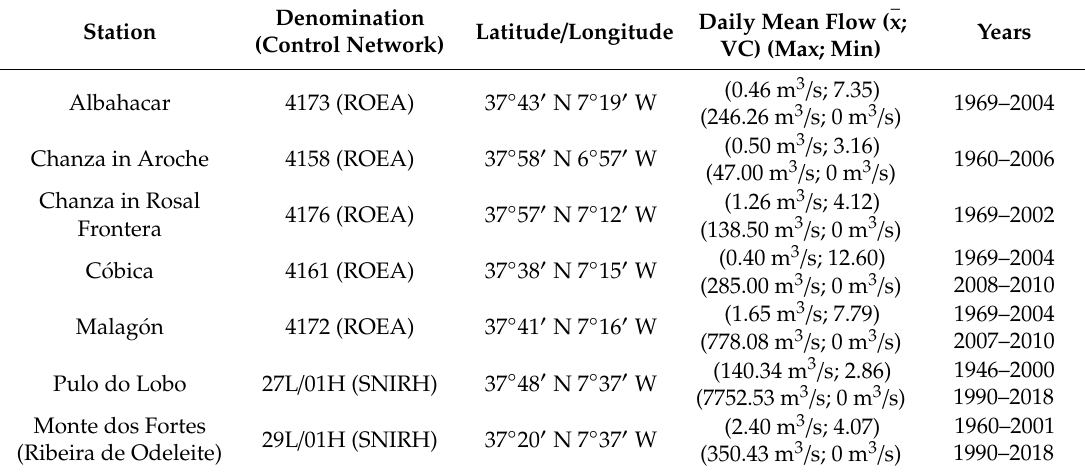
Table 2. Characteristics of gauging stations in strategic water bodies at the Lower Guadiana River − x = daily mean flow in m 3 / s; VC = variation coe ffi cient; max = daily maximum flow in Basin (Figure 2) ( m 3 / s; min = daily minimum flow in m 3 / s)